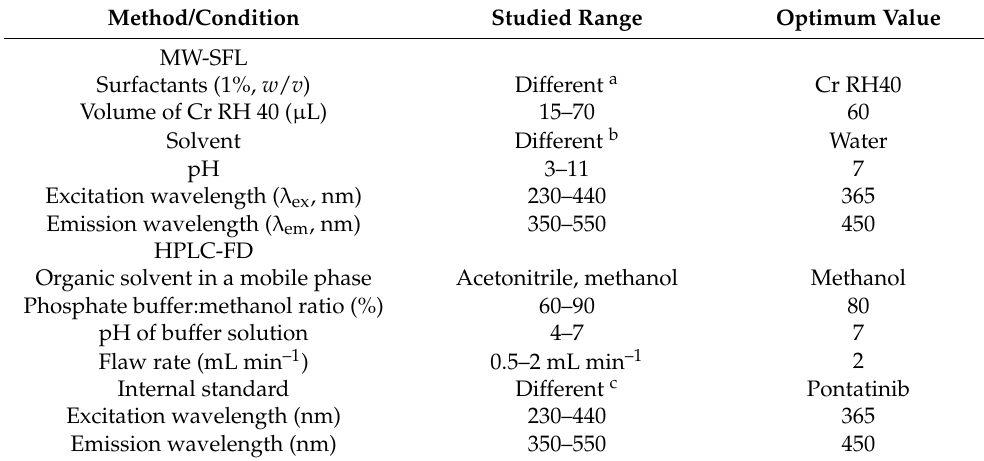
Table 1. The optimization of experimental conditions for the MW-SFL and HPLC-FD methods for determination of